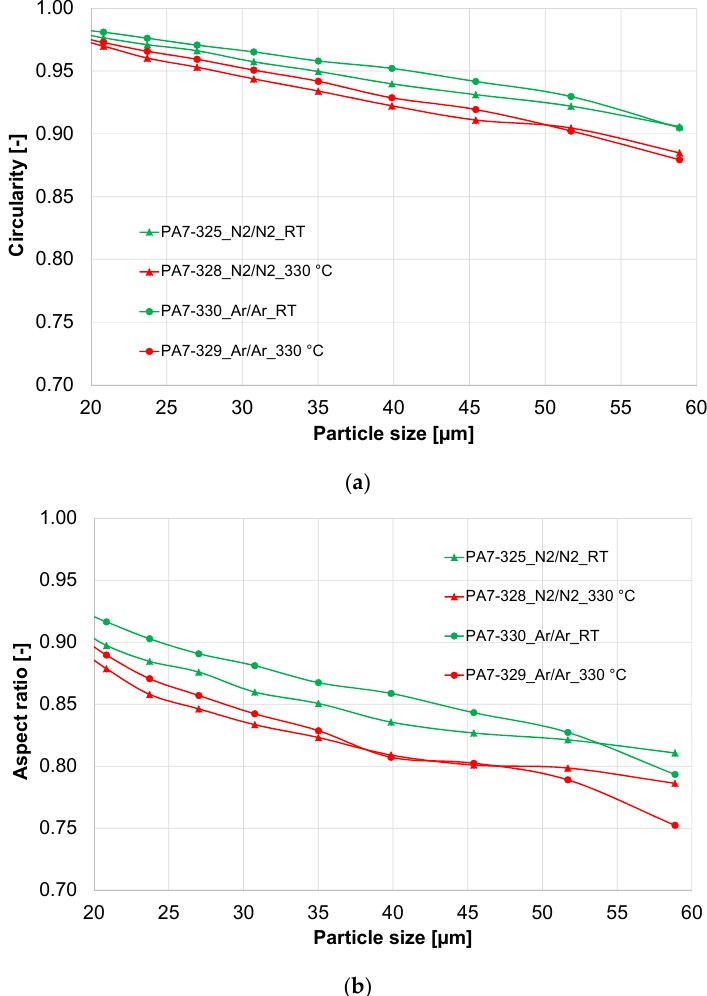
Figure 3. Shape factors of the X2CrNiMoCuWN25-7-4 powder atomized with different process gases (powder fraction 20–63 µm). ( a ) Circularity; ( b ) aspect ratio.